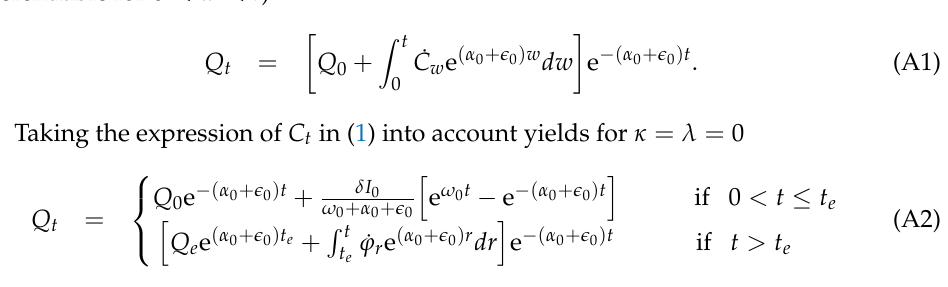
Table A2. Peak time ( t p ) and size ( ˙ ϕ p = ˙ ϕ t Model